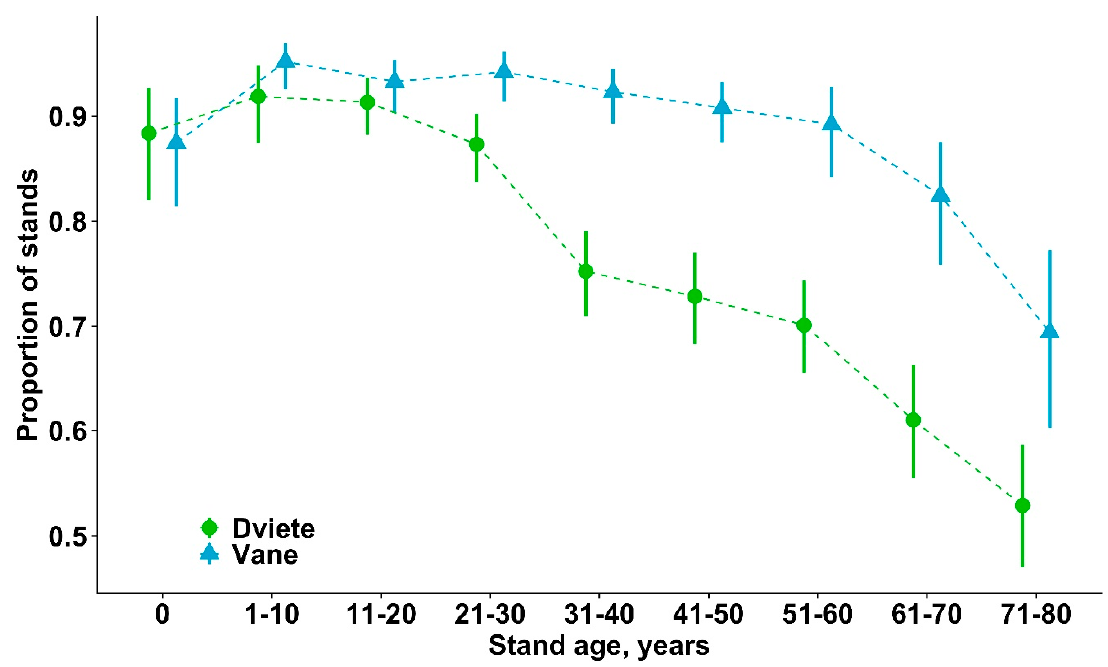
Figure 6. The site effect on the mean proportion of survival of Norway spruce stands between different age groups (±95% confidence interval).